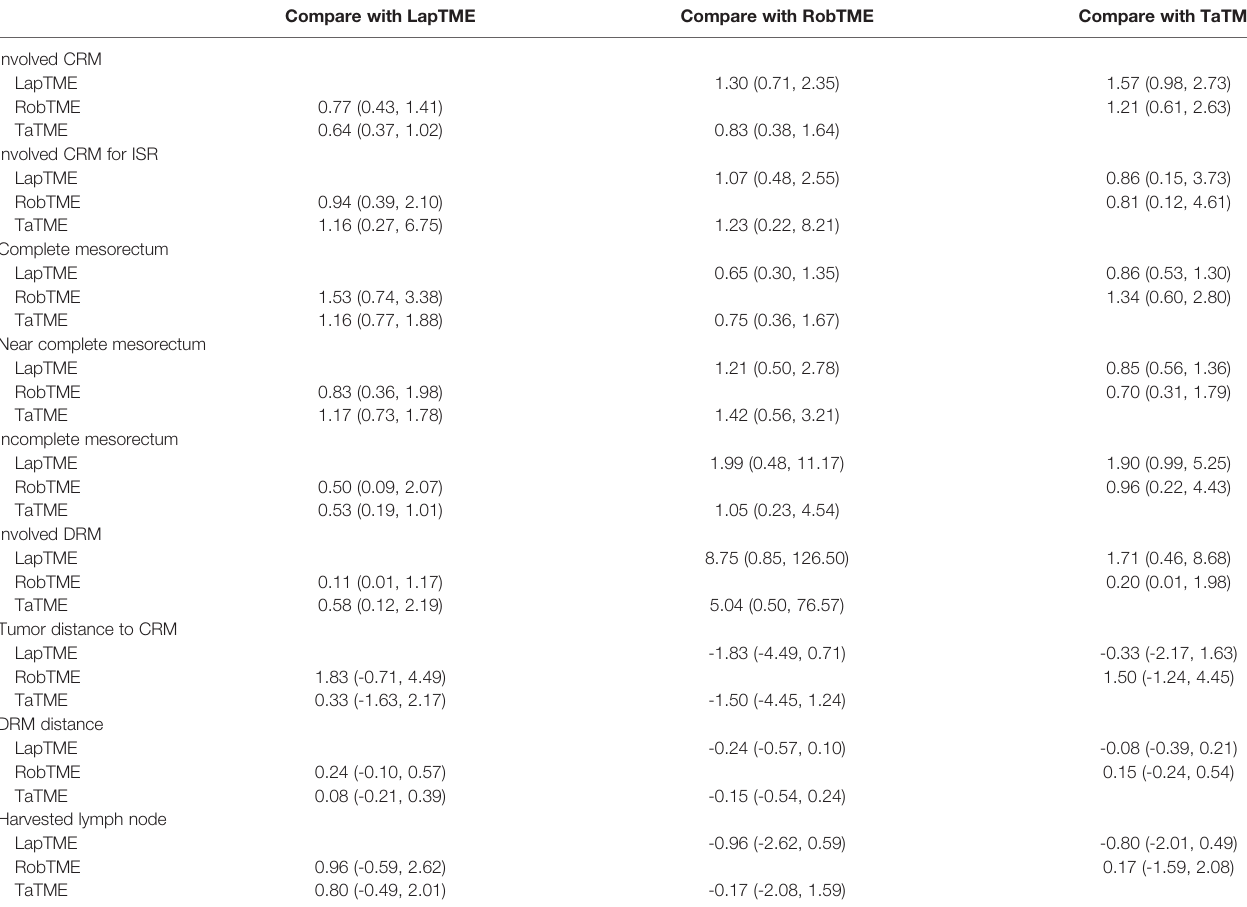
TABLE 5 | Results of network